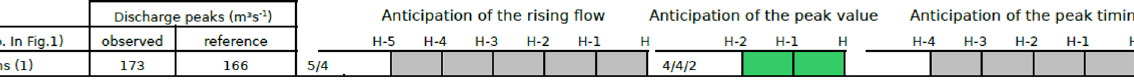
Table 4. Best anticipation of the rise in flow, peak value and peak timing simulated with ISBA-TOP driven by the AROME-NWC rainfall forecast for the watersheds affected during the events of October 2015 and 2018. The green colour (respectively orange, red) indicates an intensity error on the forecast peak lower than 10% (respectively 20%, 30%) compared to the reference peak. Streamflow observations which were provided by the French HYDRO data bank (http://www.hydro.eaufrance.fr/, last access: 11 March 2020) or by HyMeX